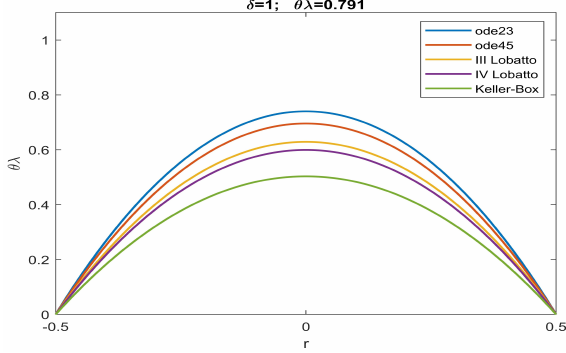
Figure 4. Recovering of u ( r ) for δ = 0.5 and θλ = 0.803.